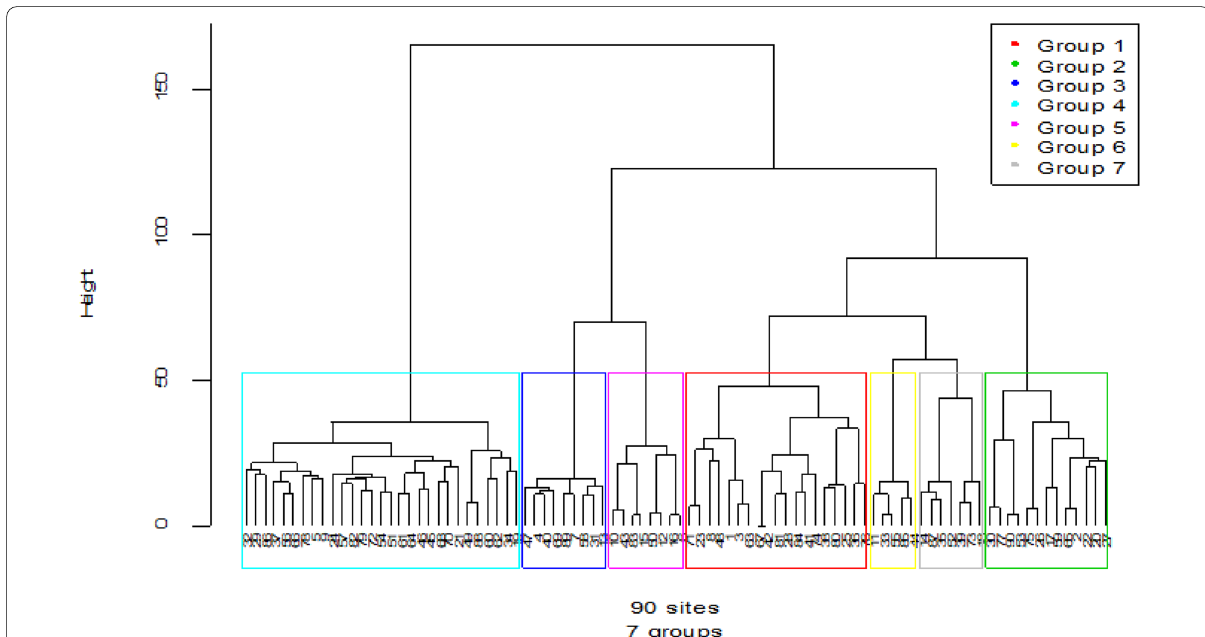
Fig. 7 Dendrogram of the vegetation data obtained from hierarchical cluster analysis of Sele-Nono forest using Ward’s method and Euclidean distance (the term ‘Group’ on the legend is synonymous to clusters or plant community types established for the study area, and represented here as C1 to C7 where plots in each community types are presented within the parenthesis as follow: C1(71,23,8,48,1,3,63,67,42,81,28,84,41,74,38,80,25,3 6,76), C2(30,77,90,53,75,26,17,59,65,22,2,20,27), C3(47,4,40,69,89,70,58,31,13),